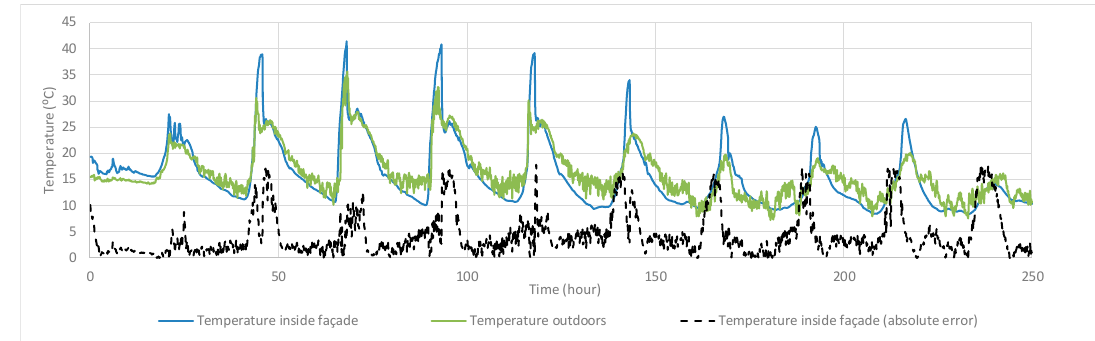
Figure 6. Absolute error of the predicted temperature inside the façade to the measured value from 5–15 November.